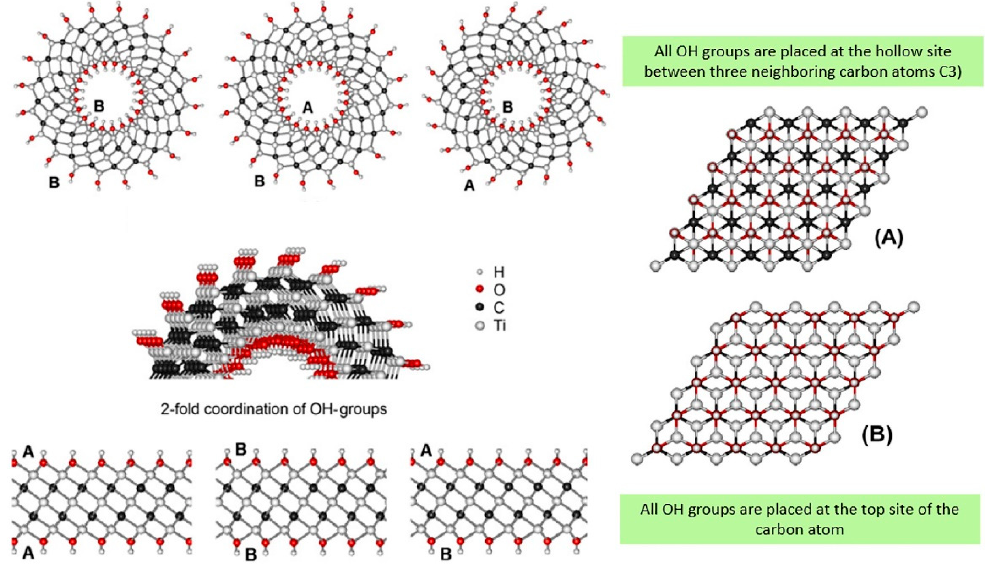
Figure 8. The arrangement of –OH termination at positions ( A , B ) in the inner and outer walls of Ti 3 C 2 T x MXene nanotubes. Reprinted with permission from Ref. [64]. 2012,